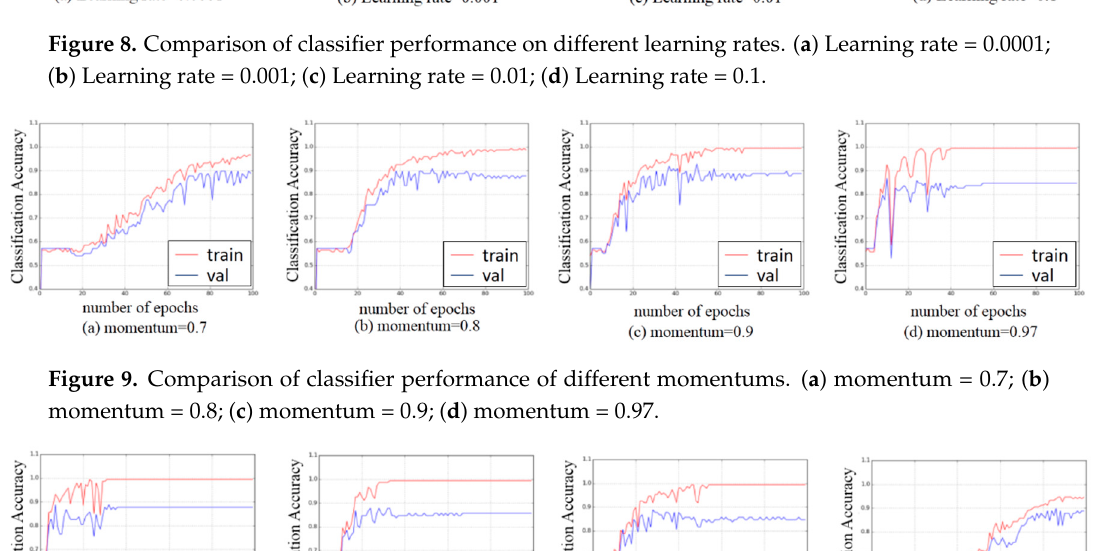
Figure 10. Comparison of classifier performance of different batch sizes. ( a ) batch size=1; ( b ) batch size=2; ( c ) batch size=4; ( d ) batch size=16.